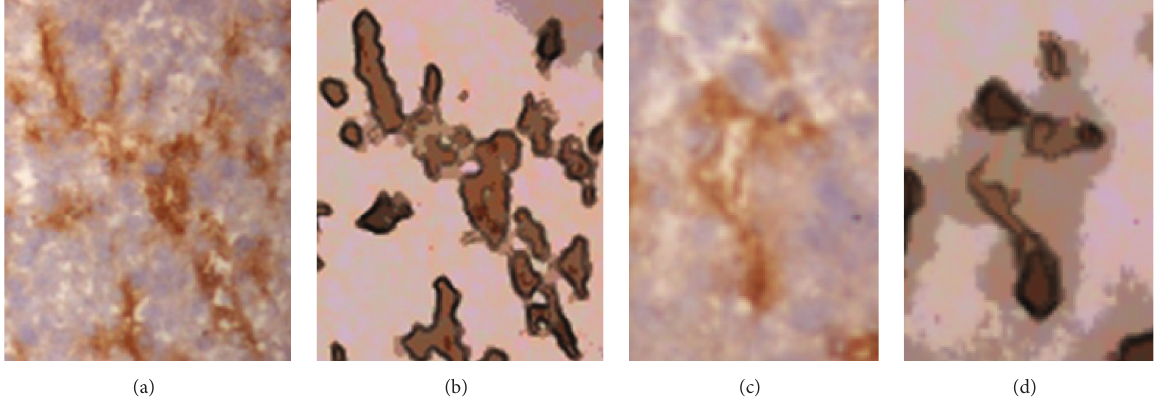
Figure 10: (a) Detail from Figure 2(a) with low contrast in the blood vessel regions. (b) Result of our proposed method with salient blood vessel regions. (c) Detail from Figure 2(a) with the cavity of the blood vessel surrounded by a few blood vessel wall areas. (d) Result of our proposed method with broken